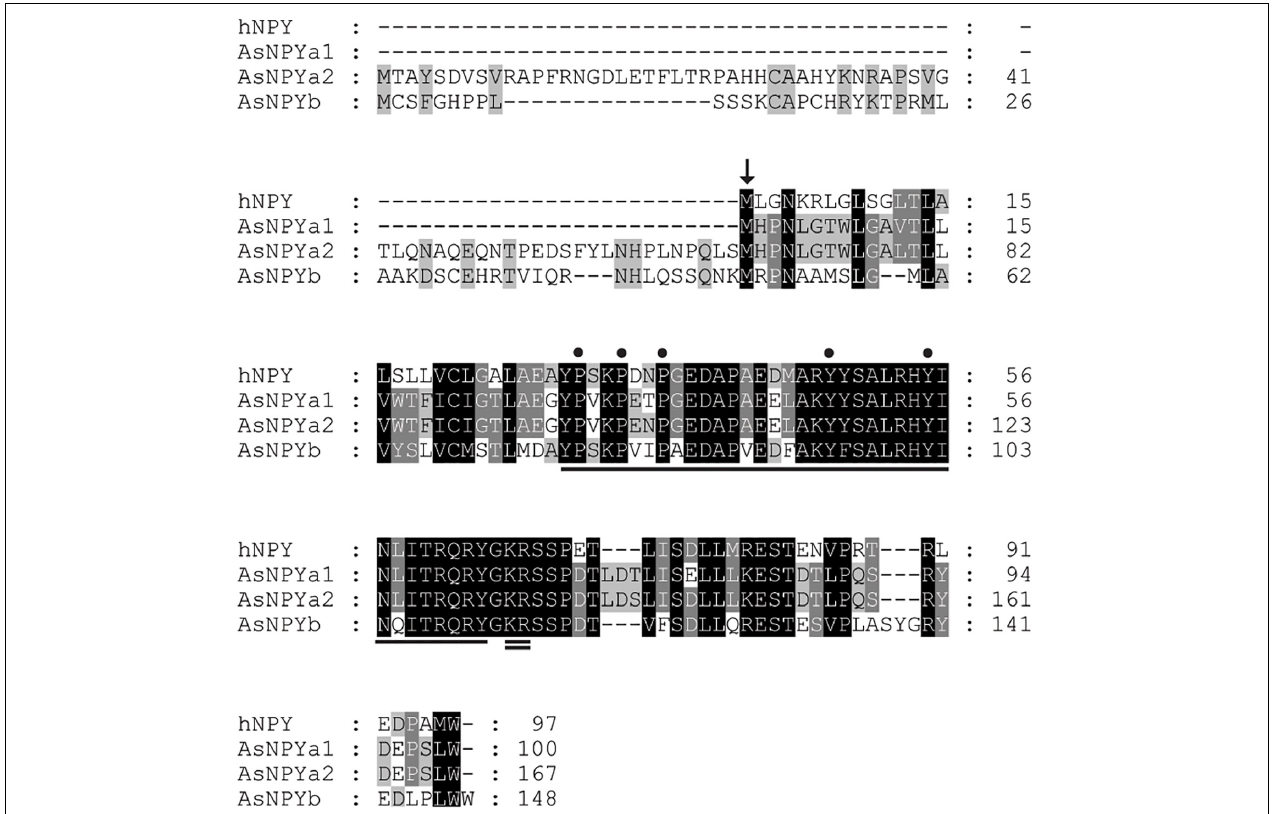
FIGURE 1 | Primary protein sequence alignment of the human neuropeptide Y (NPY) and the Atlantic salmon NPY paralogs (NPYa1, a2 and b). Arrow indicates the beginning of the predicted signaling peptide for the human NPY. Underline indicates the mature NPY sequence and double underline indicates the conserved processing amino acid sites (KR). The three proline (P) and two tyrosine (Y) residues, which are imperative to the conformation of the NPY family, are indicated by